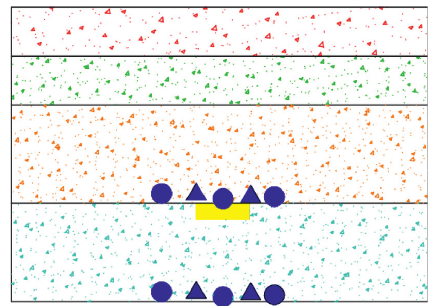
Figure 13: Schematic diagram of layout.